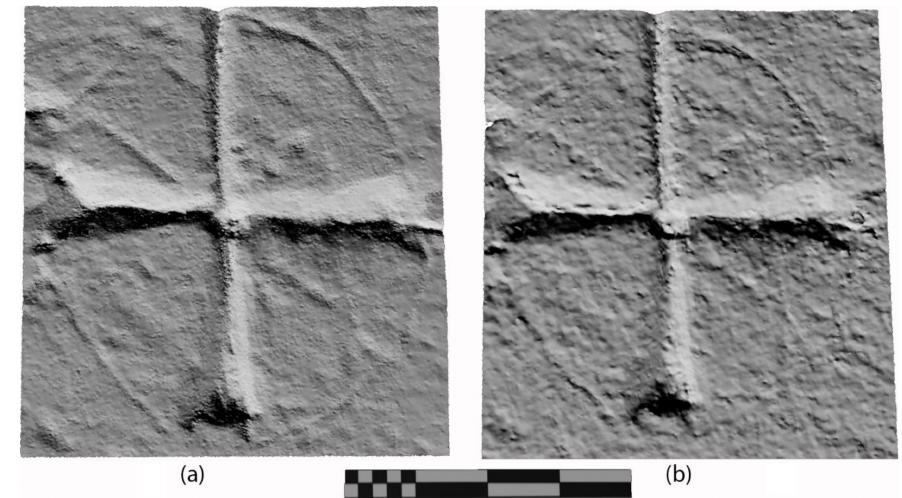
Figure 7. Detail from Surface A: ( a ) Combo 1; ( b ) a test model where only one image per camera position were included. The comparison shows that the variation in illumination in the images used for generating the Combo 2 model have made it more detailed than the test model. The scale shown is 2 cm. Both images are available in full resolution online.